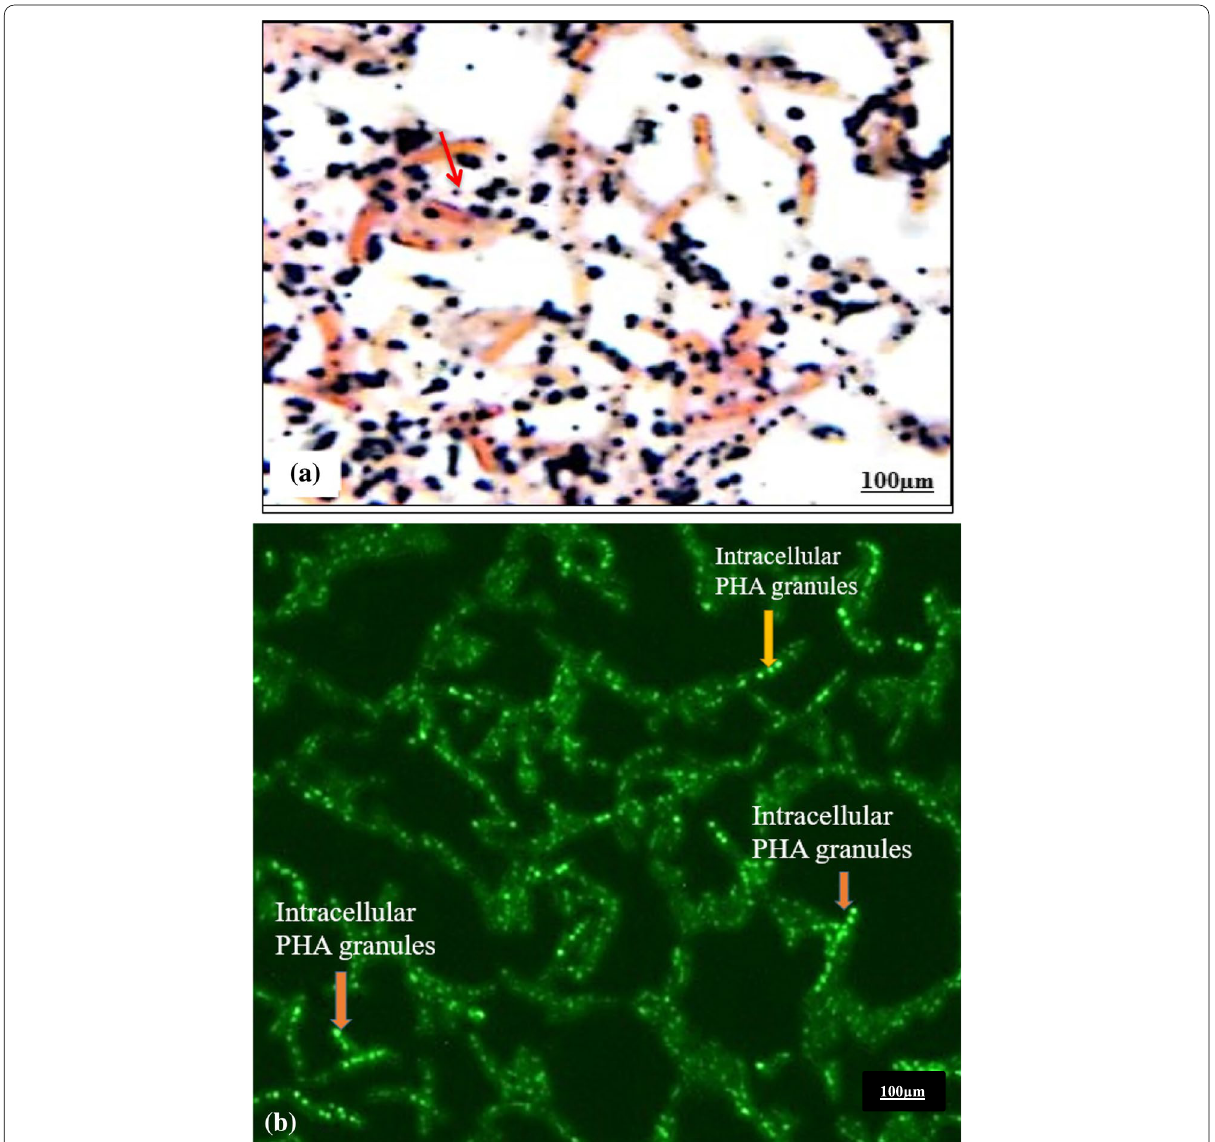
Fig. 1 Sudan Black B (SBB) and Nile blue A staining for PHA-producing Bacillus species slide staining. a Bacillus sp. LPPI-18 is a PHA-positive isolate with a better indication of SBB positivity for slide staining. b Bacillus sp. LPPI-18 is an NBA-positive endospore former obtained from Loktak Lake sediments and stained with 1% NBA